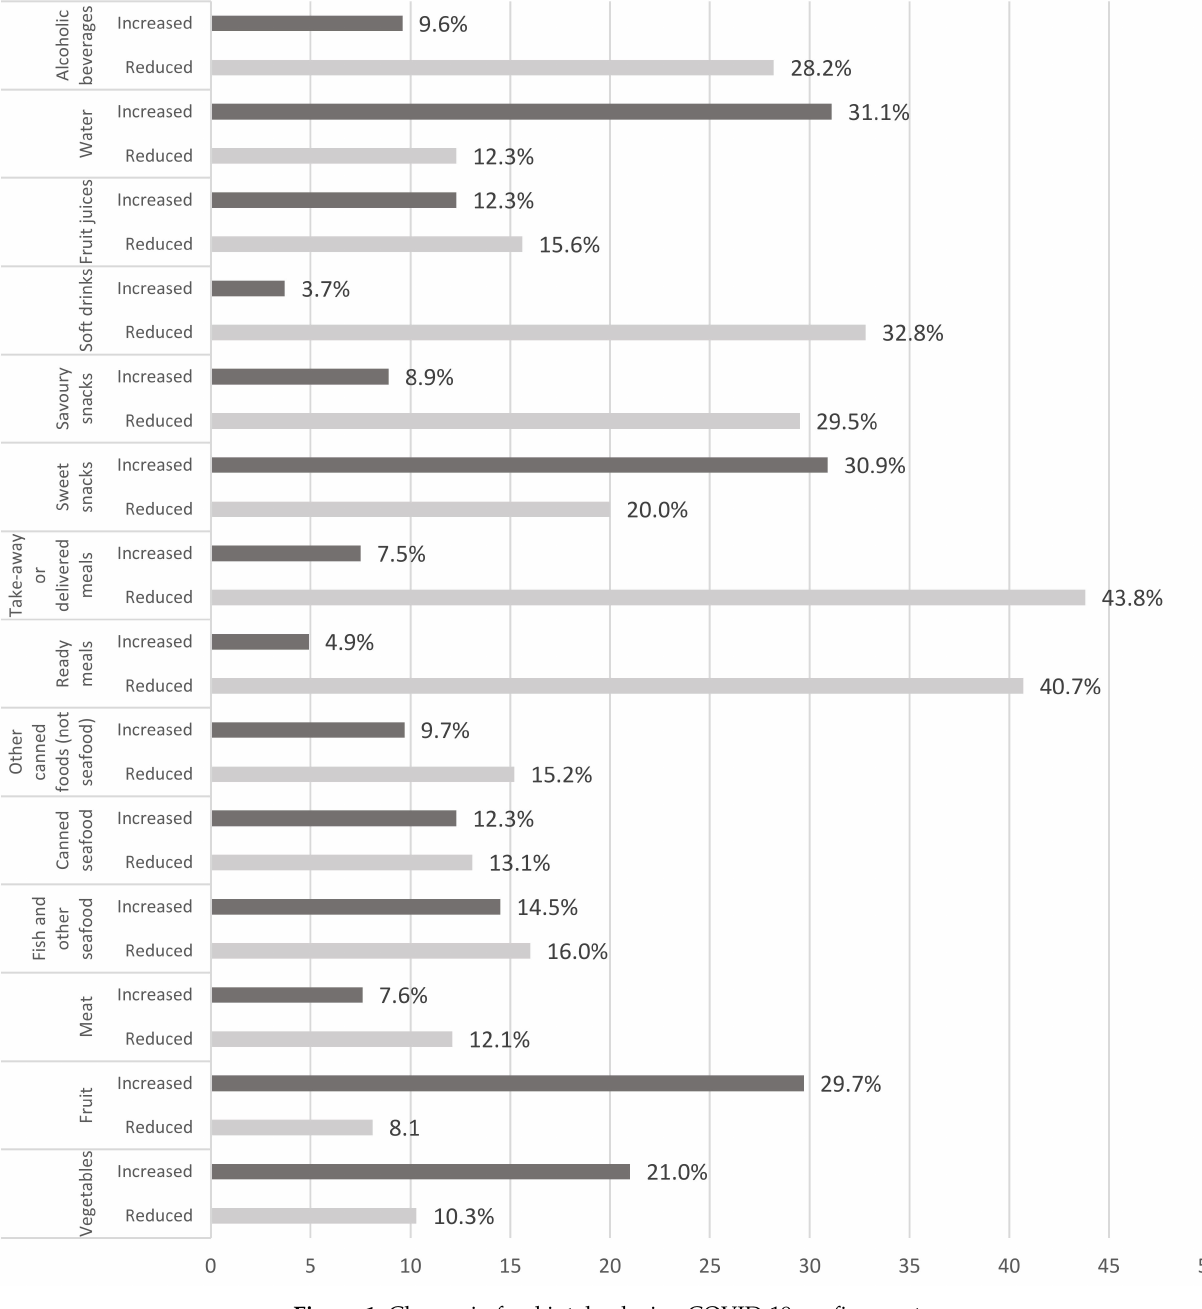
Figure 1. Change in food intake during COVID-19